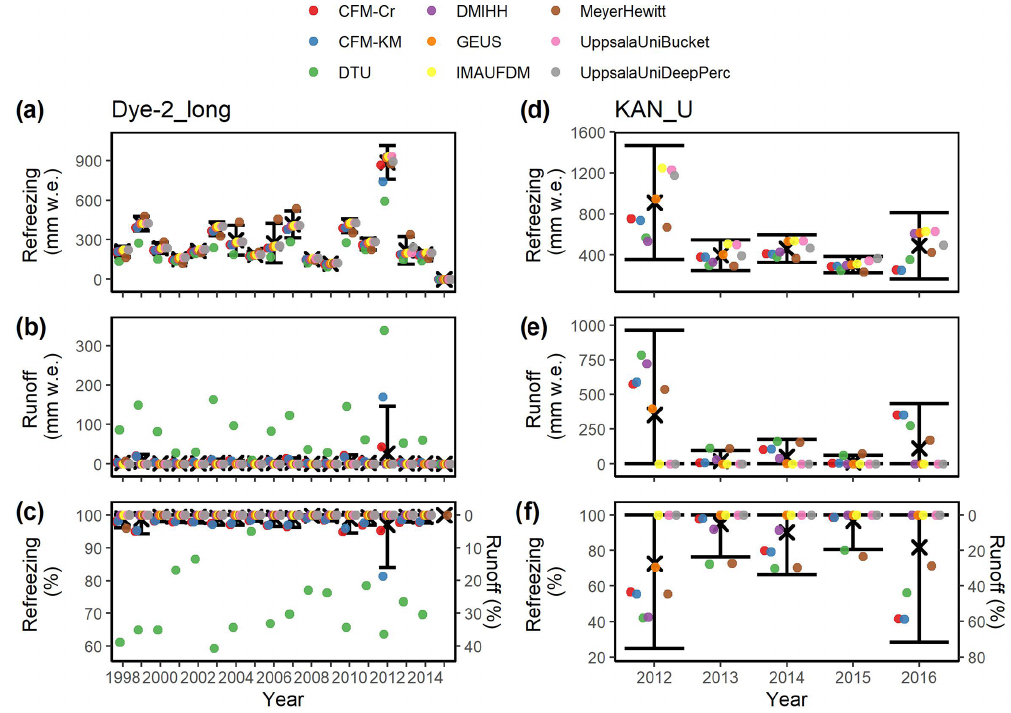
Figure 11. Simulated meltwater refreezing and runoff at Dye-2 (a, b, c) and KAN_U (d, e, f) , either as yearly totals (a, b, d, e) or as fractions of yearly total meltwater input (c, f) . For each panel, yearly intermodel averages (black cross) and ± 2 σ values (error bars) are calculated from all models except the DTU